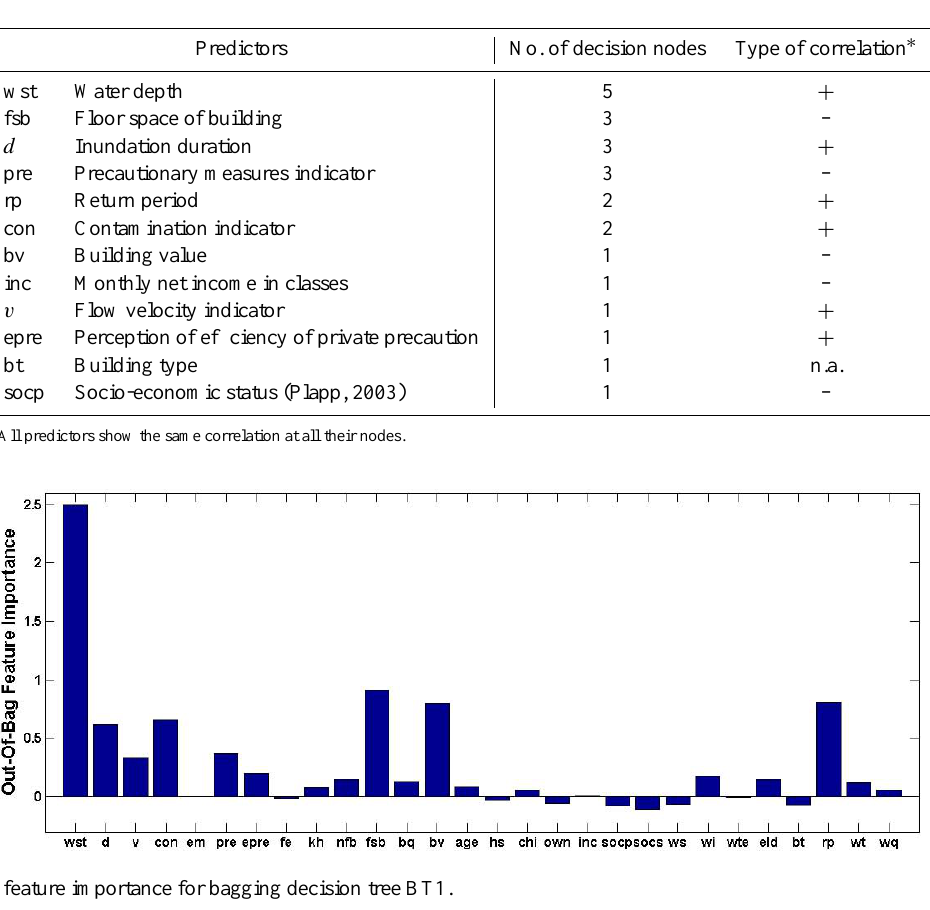
Table 2. Damage-influencing variables of regression tree RT1 with 25 leaves.